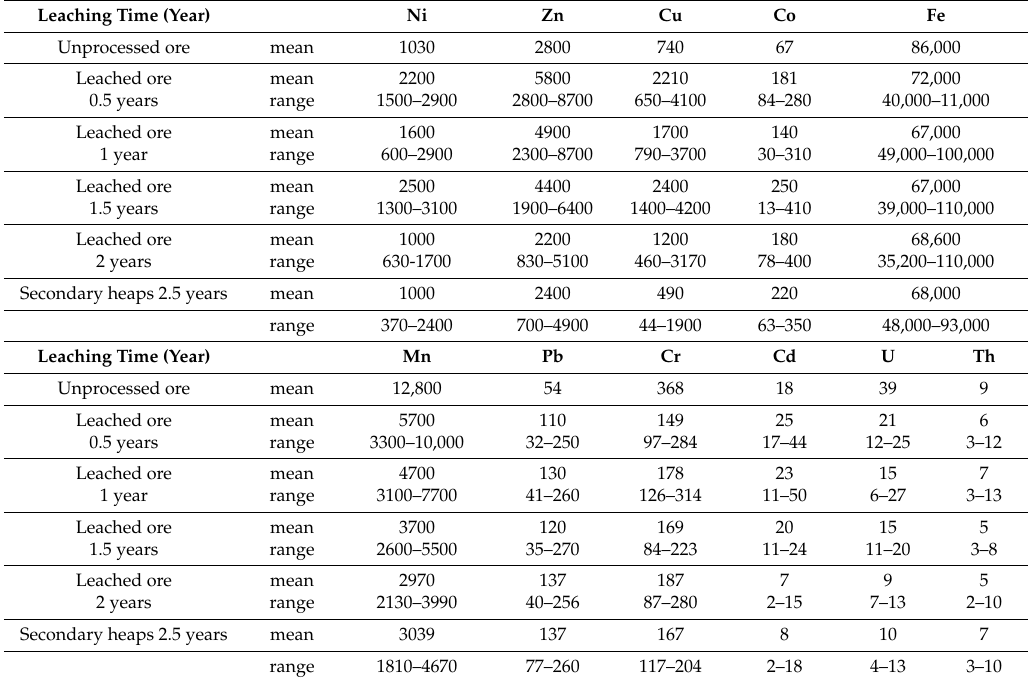
Table 3. Metal concentrations (ppm) in the unprocessed Talvivaara ore and in the leaching heaps. Leaching times are approximate